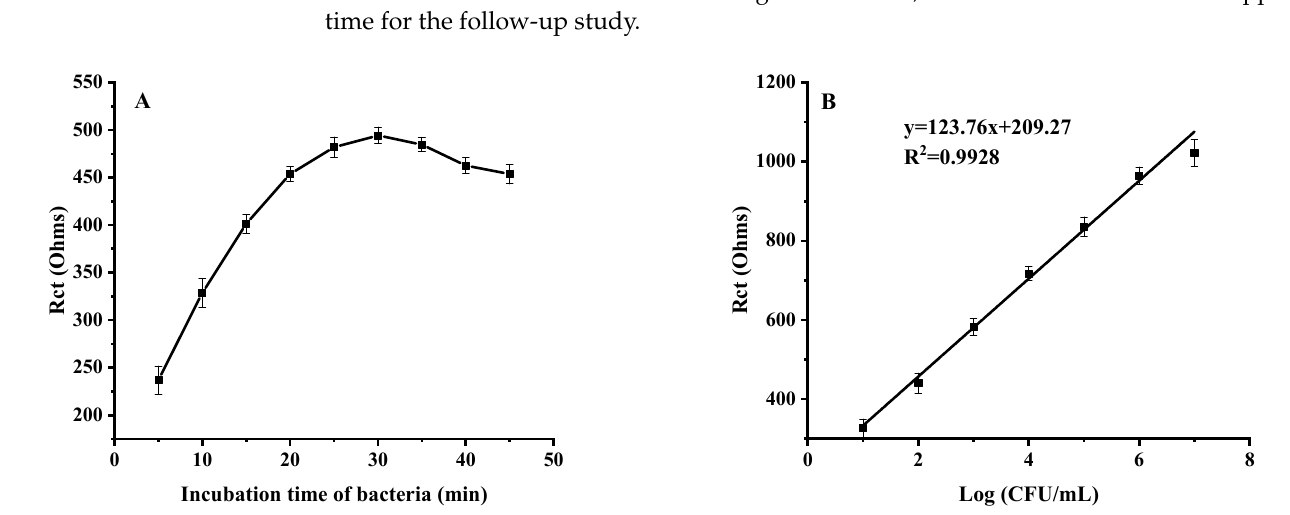
Figure 6. Graph of Salmonella testing in PBS. ( A ) Incubation time of phage L66-based working electrode with bacteria. ( B ) The calibration curve of the biosensor with different concentrations of Salmonella .